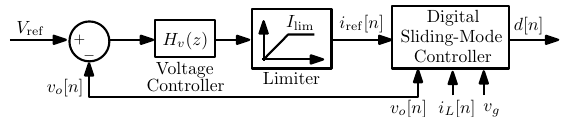
Figure 6. Control scheme with a two-loop voltage